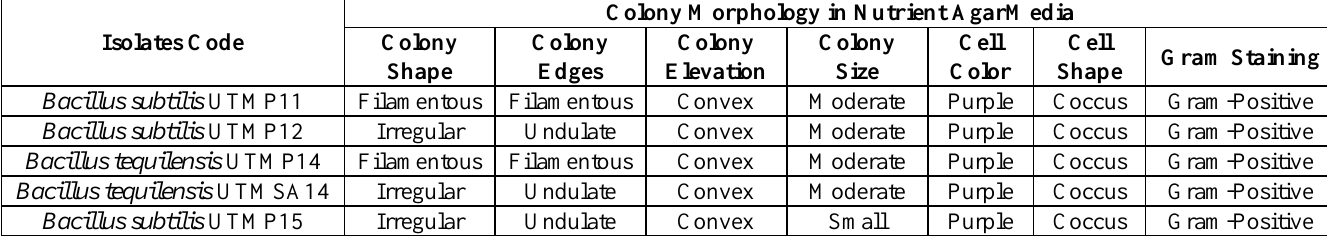
Table 2: Microscopic and macroscopic morphological tests for Bacillus subtilis UTMP11, Bacillus subtilis UTMP12, Bacillus tequilensis UTMP14, Bacillus tequilensis UTMSA14, and Bacillus subtilis UTMP15. Isolates